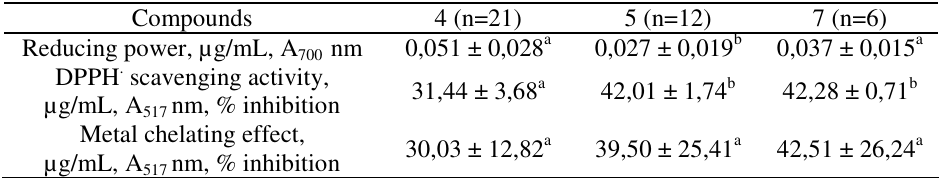
Table 1. The comparison of reducing power, DPPH . scavenging, and chelating activities of compounds 4 , 5 , and 7